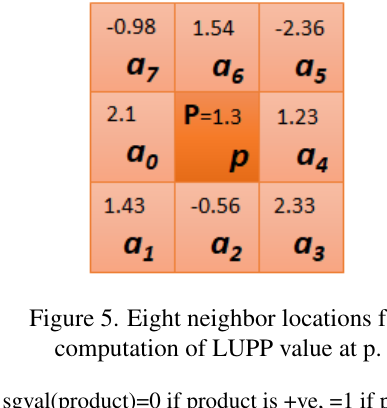
Figure 4. Computing GUPP value at location p from complex coefficient images at six different orientations.